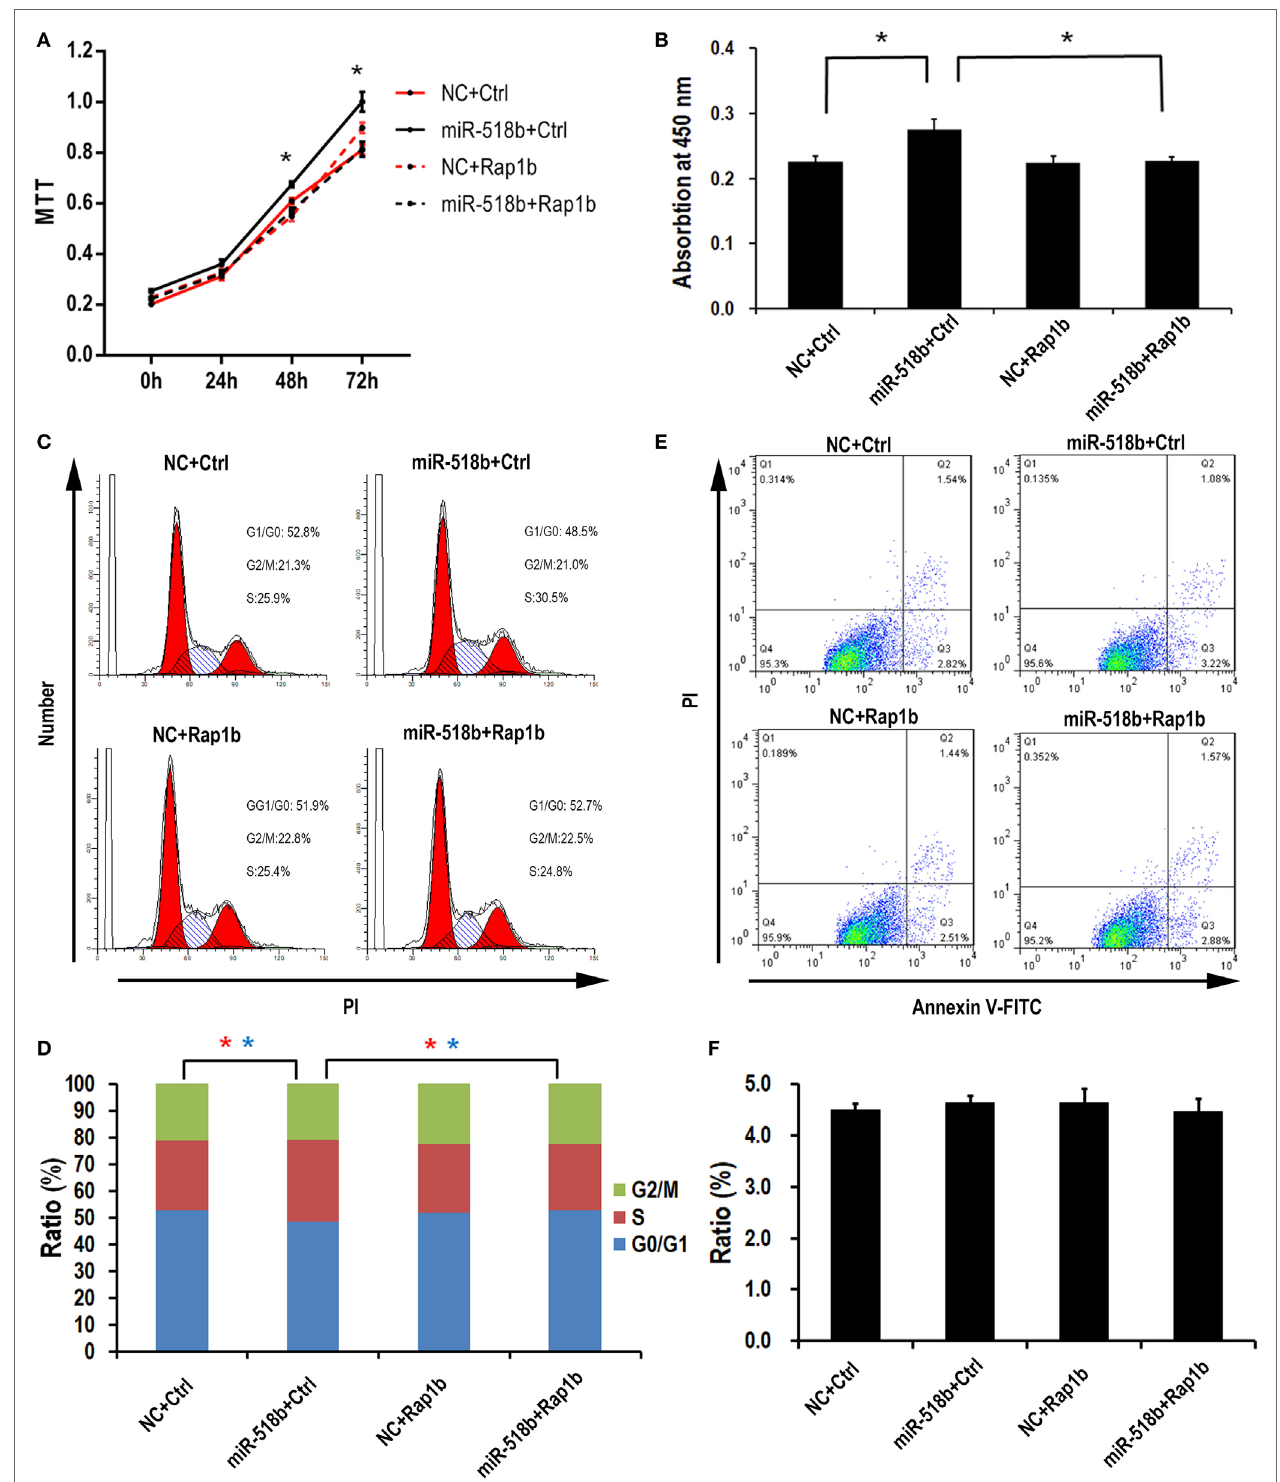
FigUre 4 | miR-518b transfection accelerates the cell proliferation. (a) MTT assay to measure the cell viability in HTR8/SVneo cells. The cells were transfected with miR-518b together with Rap1b overexpression plasmid, and MTT assays were performed at 24, 48, and 72 h after transfection. (b) BrdU incorporation assay to measure the cell proliferation in HTR8/SVneo cells transfected with Rap1b overexpression plasmid. (c,D) Cell cycle assay for HTR8/SVneo cells transfected with Rap1b overexpression plasmid. (e,F) Costaining of propidium iodide (PI) and FITC-Annexin V for cell death/apoptosis assay for HTR8/SVneo cells transfected with Rap1b overexpression plasmid. MTT assay was replicated for five times, and other tests were replicated for three times. Data are presented as mean ± SEM. * P < 0.05.